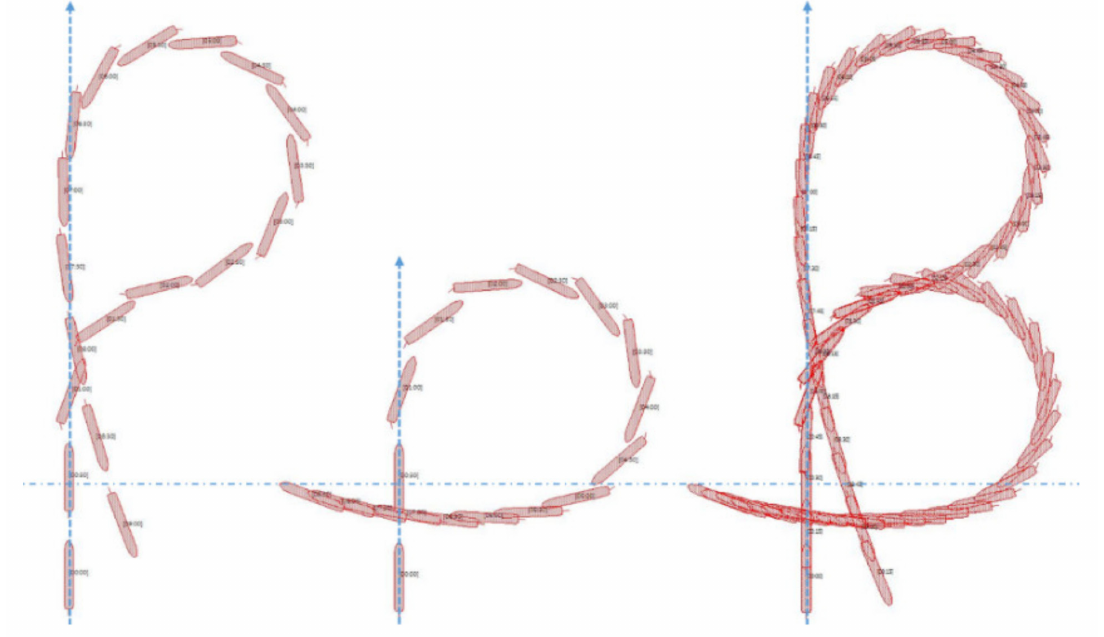
Figure 12. Williamson turn ( left ) and Anderson turn ( middle ) and turns overlaid ( right